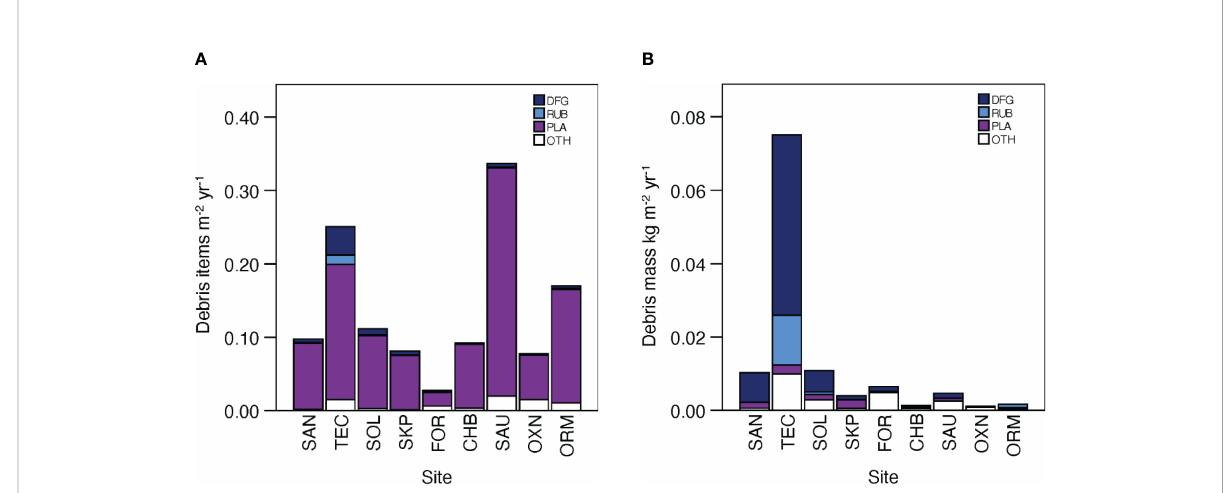
FIGURE 4 Mean number of debris items (A) and mass (B) collected by site and debris composition. Number of items and mass was standardized by area and by days since the previous survey. Plastics (PLA) was the largest category in terms of number of items removed, and fi shing gear (DFG) was the largest category in terms of the mass of debris